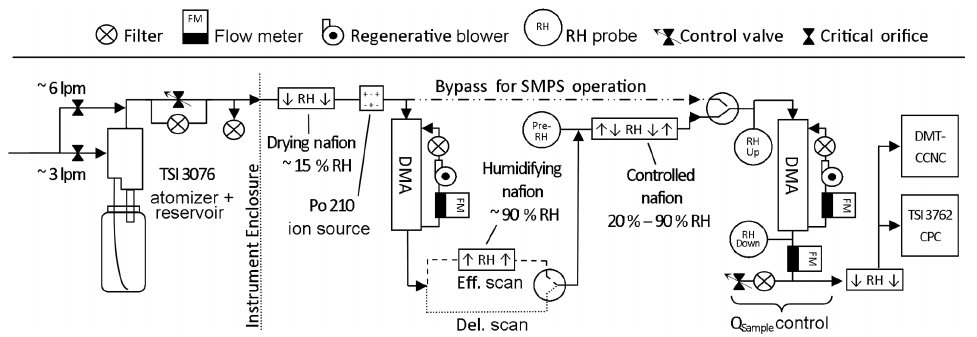
Figure 1. TDMA and SMPS–CCNc